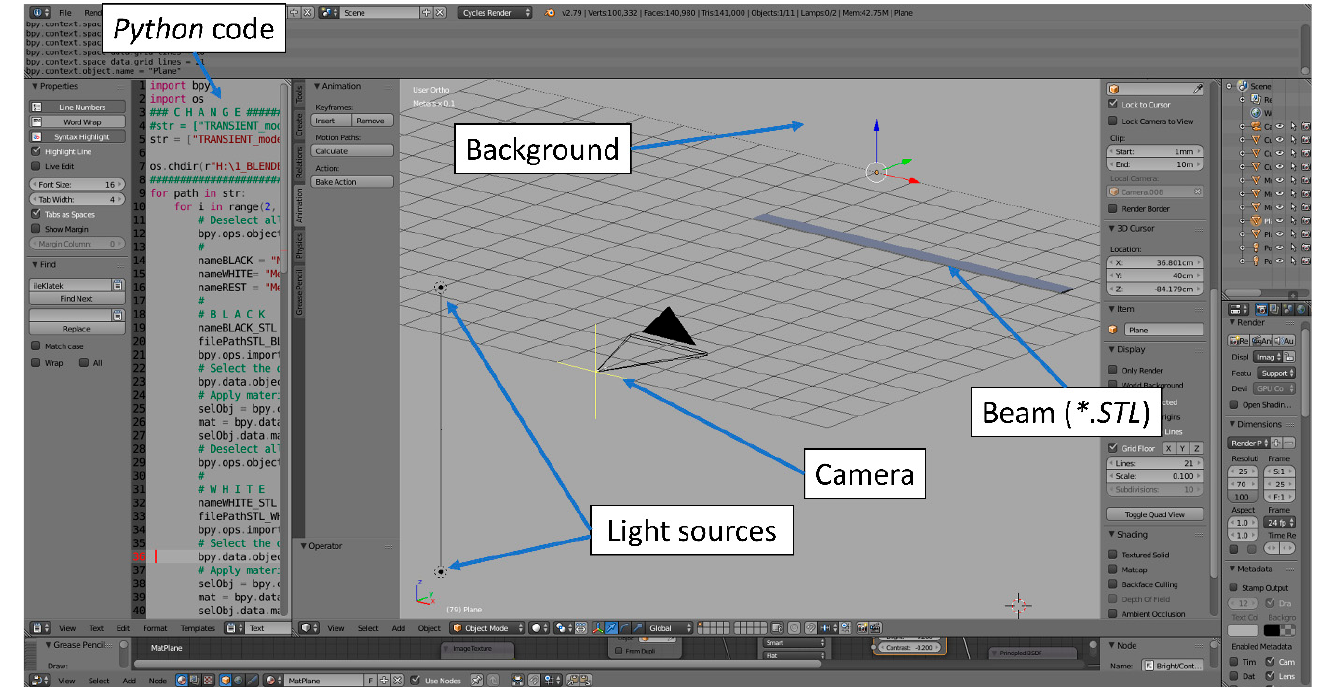
Figure 8. The model in the Blender environment for the beam’s deflection rendering process.